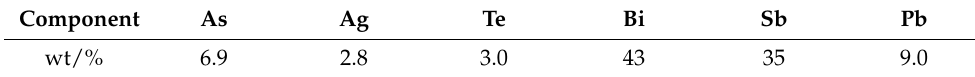
Table 3. Chemical compositions of tellurium condensate (wt%).